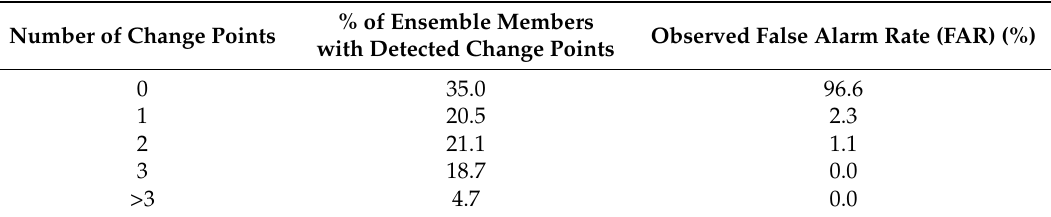
Table 5. As Table 4 but for the drifting buoy analysis.